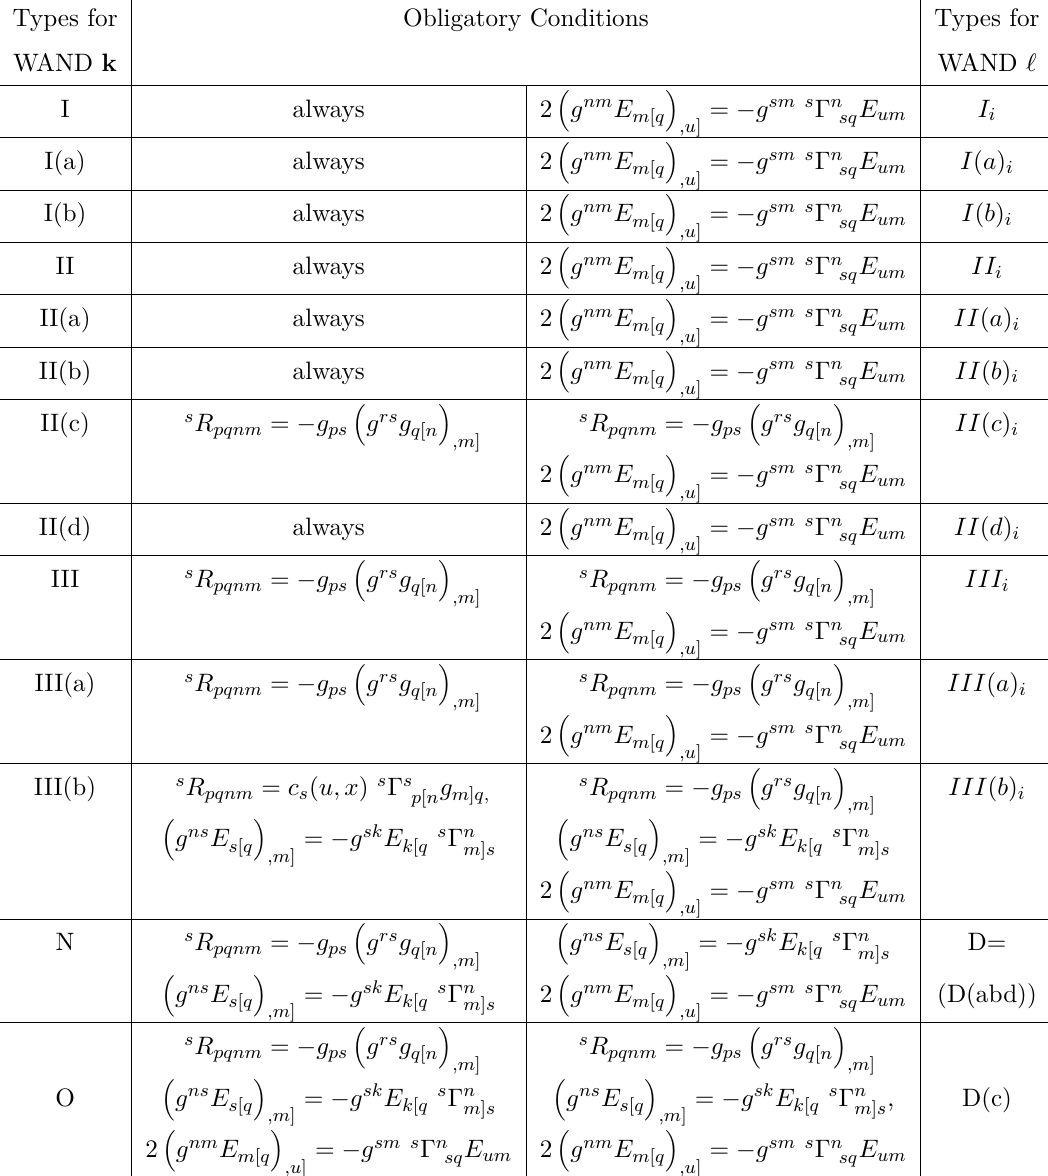
Table 3 . Higher dimensional pp-waves classification with obligatory conditions for both WANDs k and ‘ as the dimension of the spacetime D → ∞